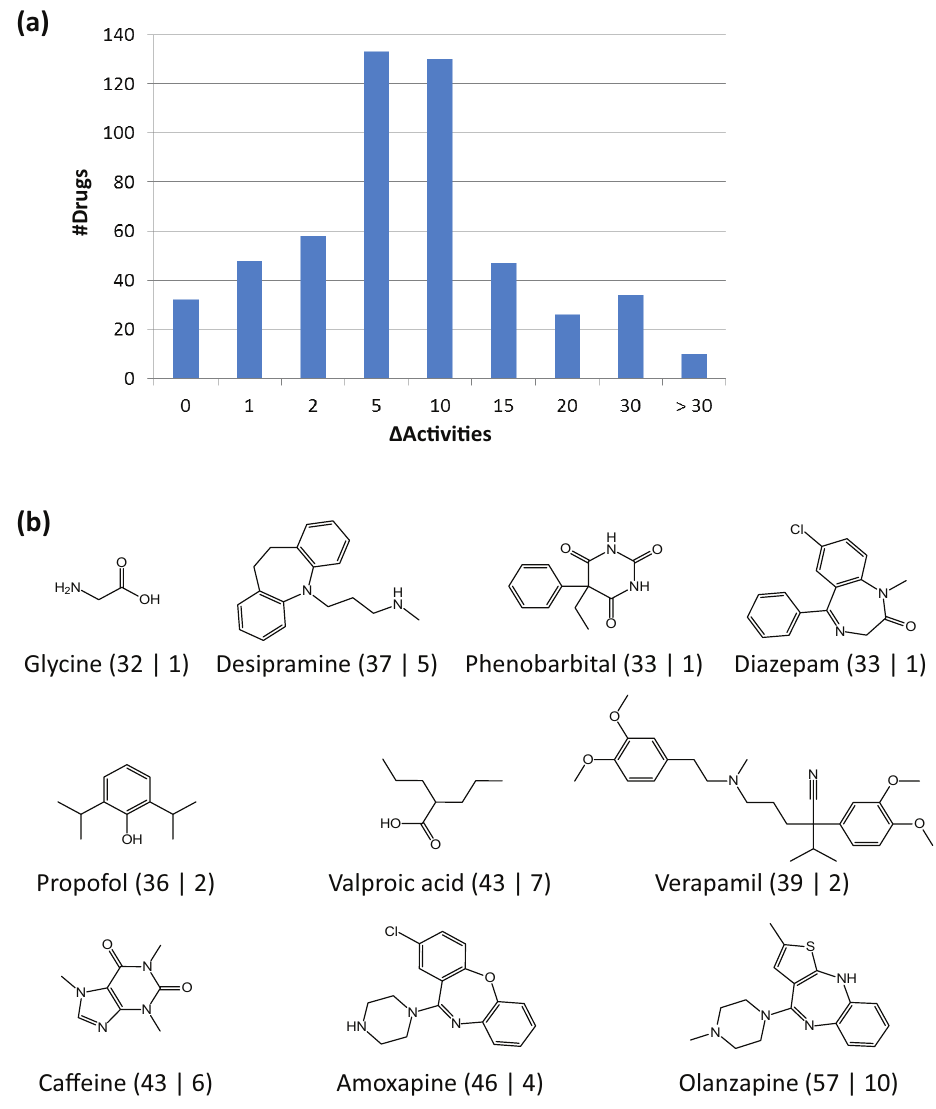
Figure 3. Promiscuity variation in DrugBank vs ChEMBL. ( a ) Reported is the distribution of promiscuity differences ( ∆ Activities) between DrugBank and ChEMBL for 518 drugs. ( b ) Shown are 10 drugs with the largest difference in promiscuity ( ∆ Activities > 30). Target annotations are represented according to Figure 2c and Figure